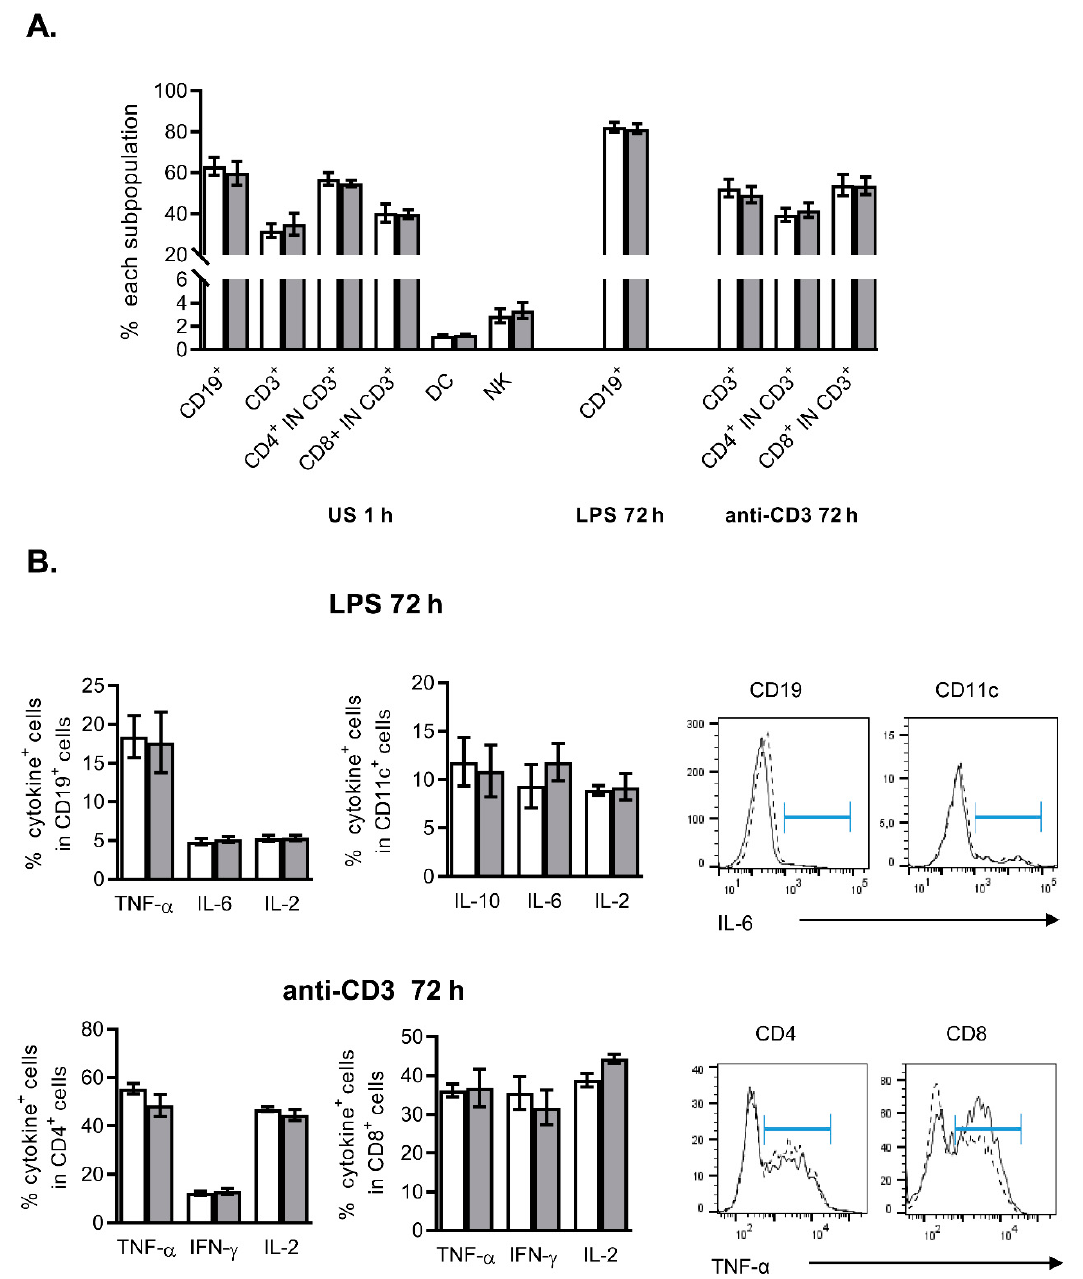
Figure 2. NanoMBGs do not alter the cell subpopulations balance or cytokine expression in stimulated mouse spleen cells. ( A ) Analysis of the di ff erent subpopulations in spleen cells unstimulated (US, 1 h) or with the indicated stimuli (72 h) in the presence (grey bars) or absence (white bars) of FITC-NanoMBGs. Unstimulated cells were incubated with FITC-NanoMBGs during 1 h. Mean ± SEM of one experiment out of two, each with three biological samples, is shown. ( B ) Analysis of cytokines produced in the spleen subpopulations shown in ( A ), in the presence (grey bars / solid line) or absence (white bars / dashed line) of NanoMBGs. Right, histograms showing the expression of IL-6 in CD19 + or CD11c + cells (upper histograms) and TNF- α in CD4 + or CD8 + T cells (bottom histograms) from one representative experiment.